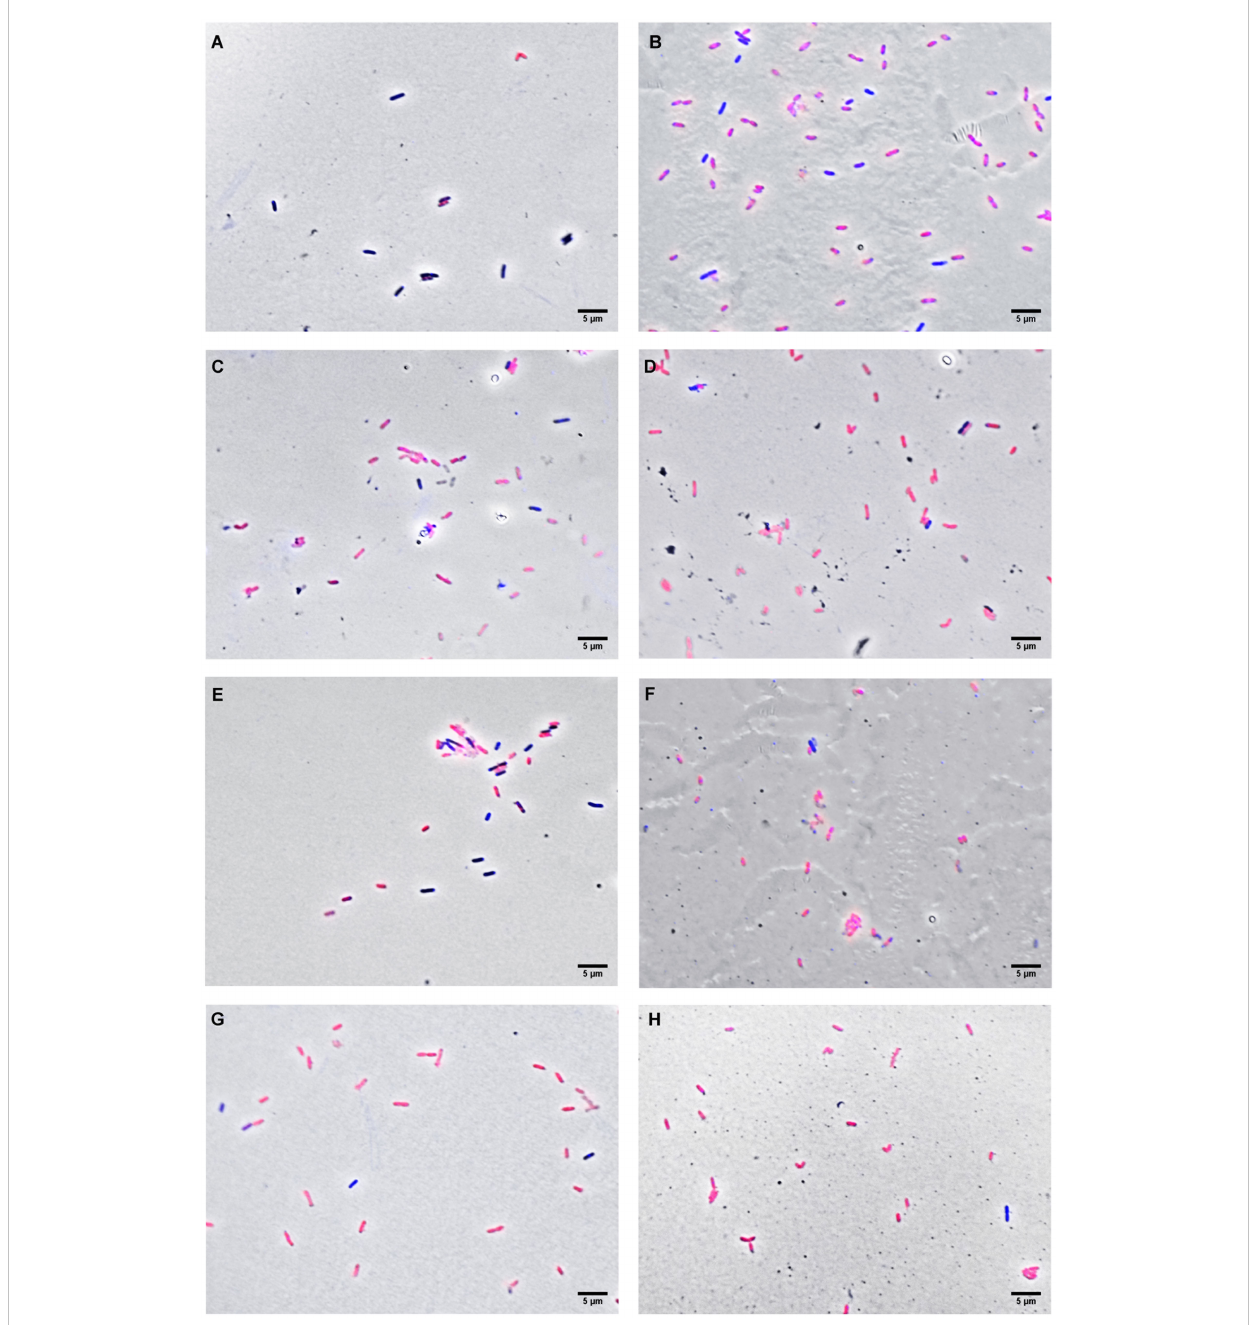
(Figure 6B). For all the compounds, an acute toxic effect was observed in all treatments above 200 μg.mL -1 , but with OEO and THY showing a lower phytotoxic effect in S. lycopersicum at lower concentrations. At 50 μg.mL -1 minor toxic effects in S. lycopersicum were exhibited for OEO and THY (GI >